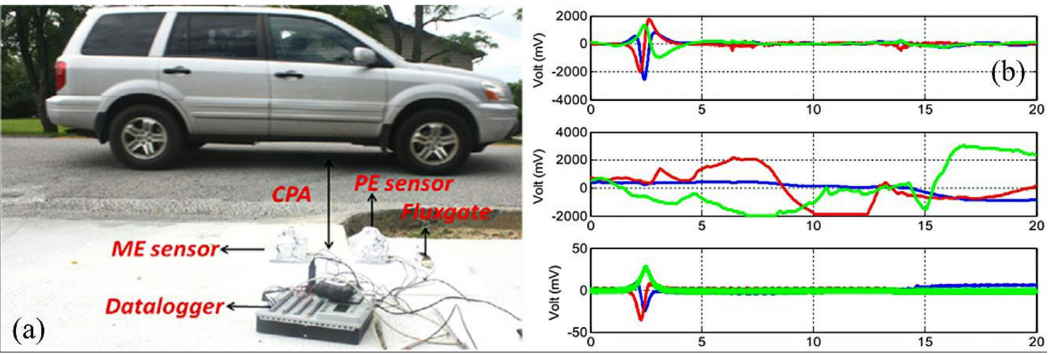
Figure 8. ( a ) Photograph of the vehicle detection system setup; ( b ) sensor output signals in terms of the X (blue curve), Y (red curve) and Z (green curve) component in the ME sensor (top), PE sensor (middle) and fluxgate sensor (bottom) [69].